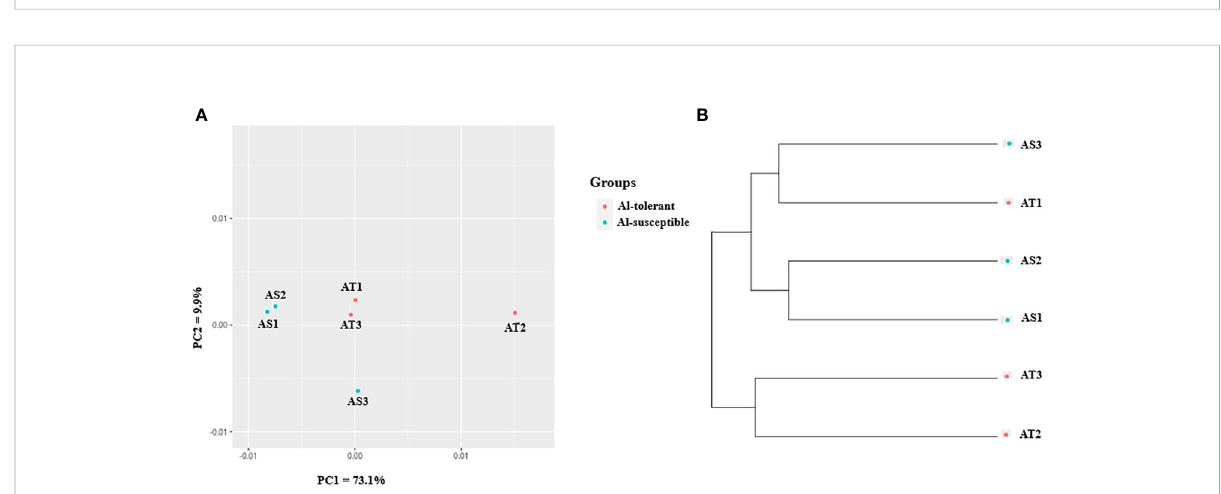
FIGURE 6 Gene expression-based (A) PCA scatter plot, and (B) UPGMA cluster depicting the relationship between the fi nger millet